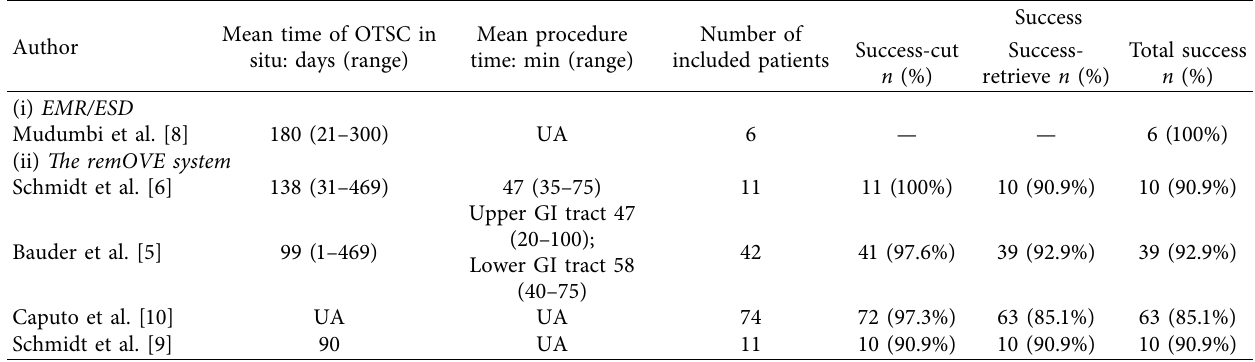
Table 4: Details of OTSC removal of the included clinical trials.